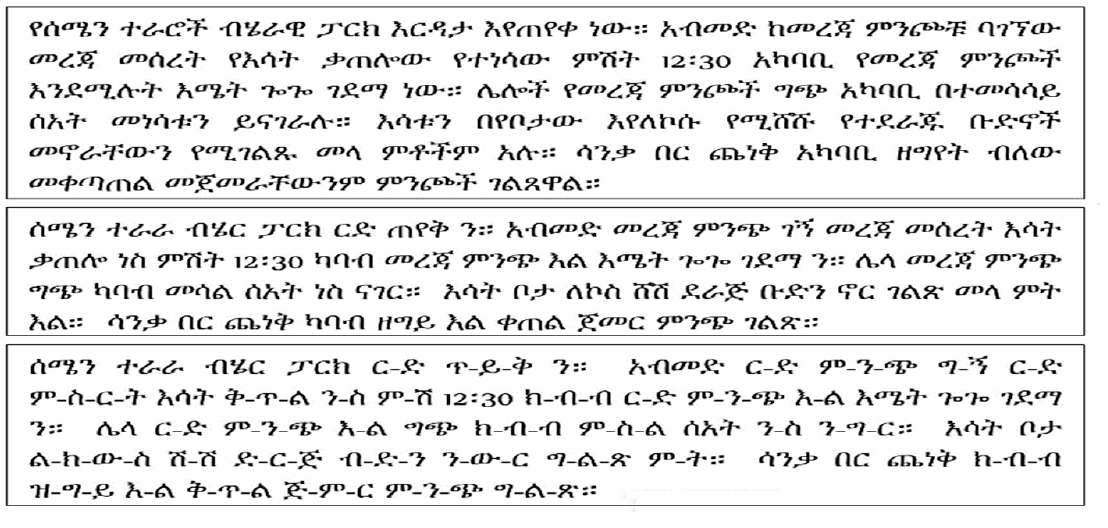
Figure 1. Representation of a document using word-based ( top ), stem-based ( middle ), and root-based ( bottom ) items.